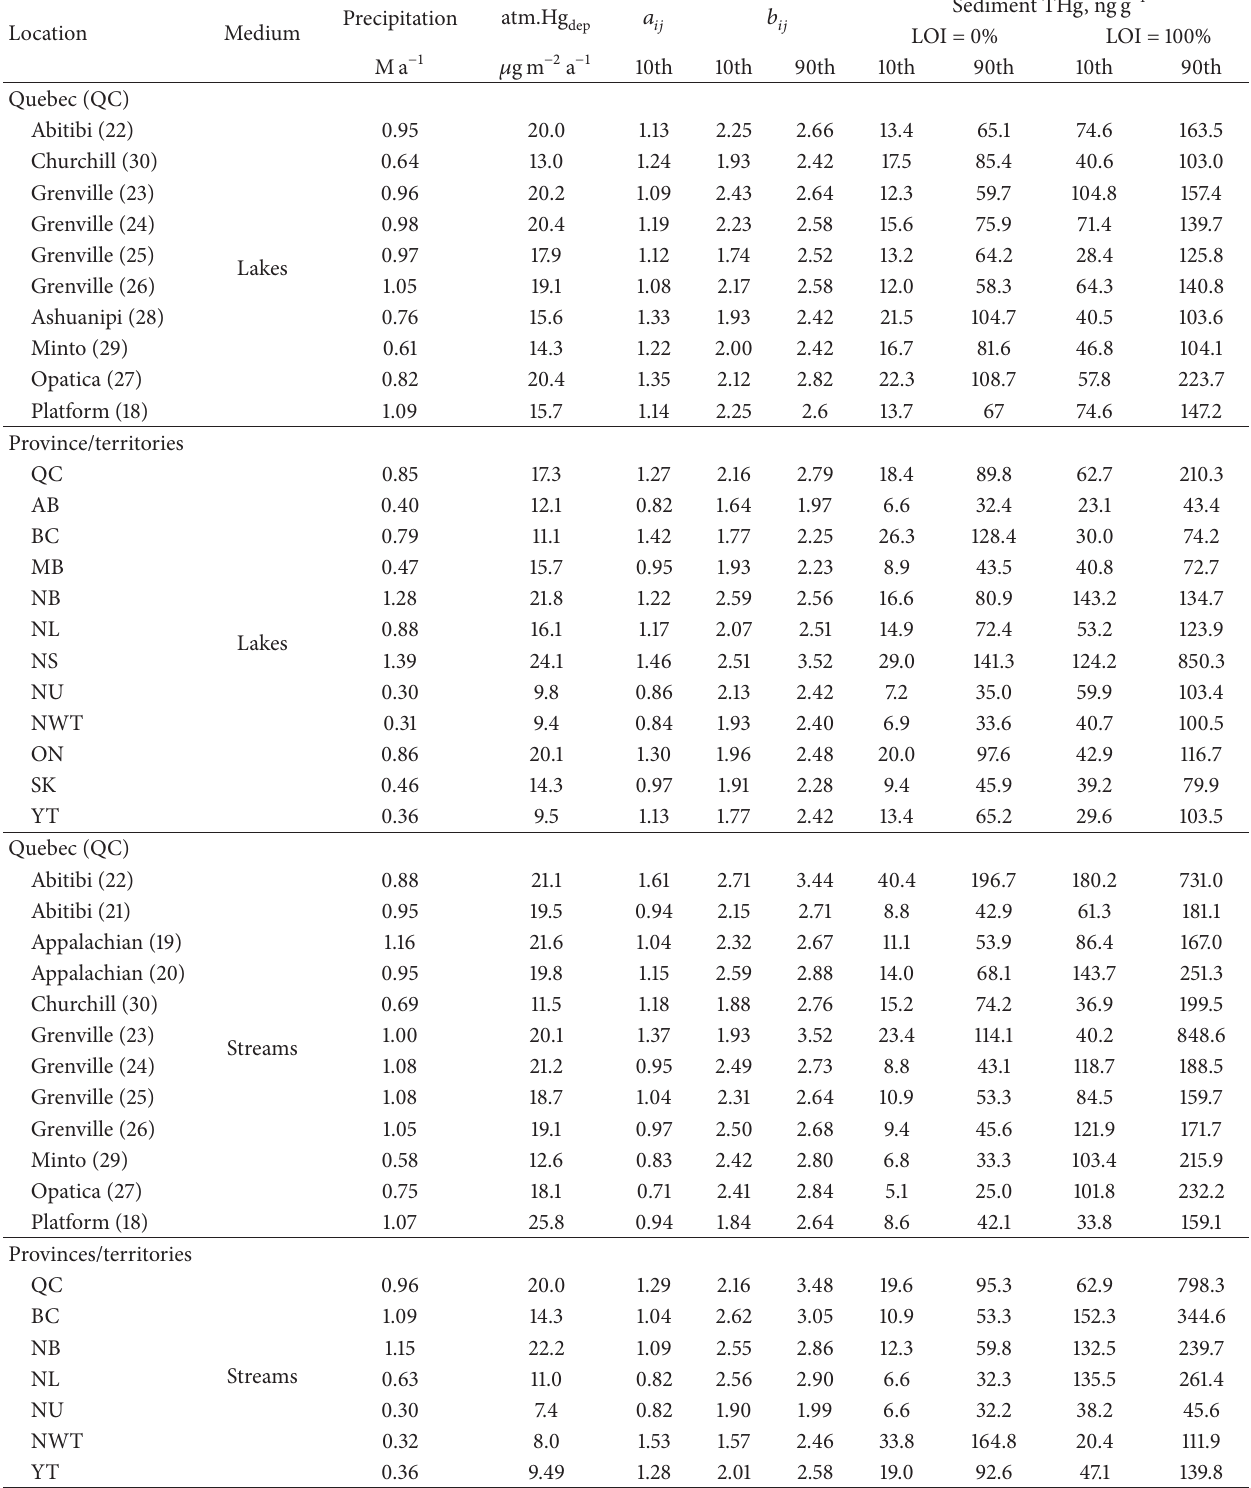
Table 3: Mean annual precipitation, mean atmospheric deposition, and best-fitted 𝑎 𝑖𝑗 , 𝑏 𝑖𝑗 , and 𝑐 𝑗 values (1) for the 10th and 90th sediment THg percentiles (lakes, streams), by provinces/territories and by Quebec survey zones (Figure